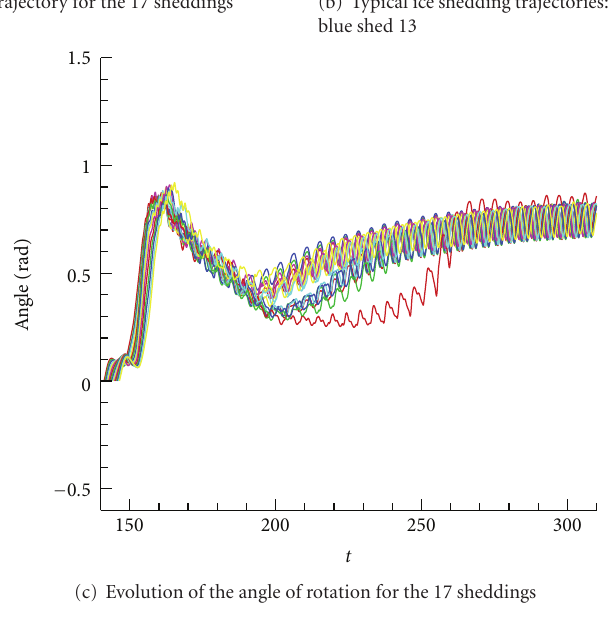
Figure 9: Ice piece